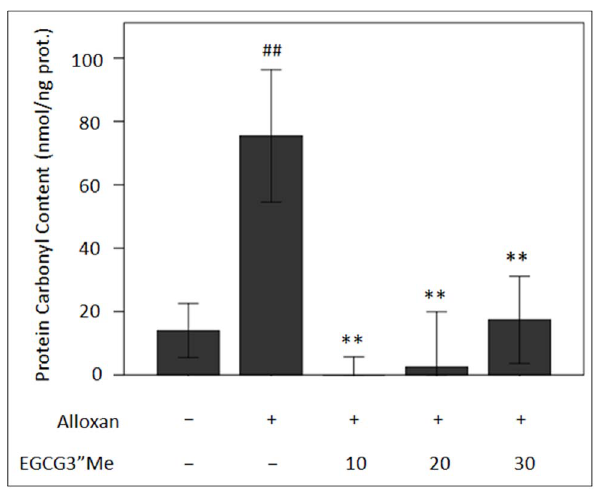
Figure 2. Inhibitory effect of EGCG3’’Me on the formation of carbonylated proteins in the serum. ## represents statistical significance vs. control group; **represents statistical significance vs. diabetes model, n=6–8.